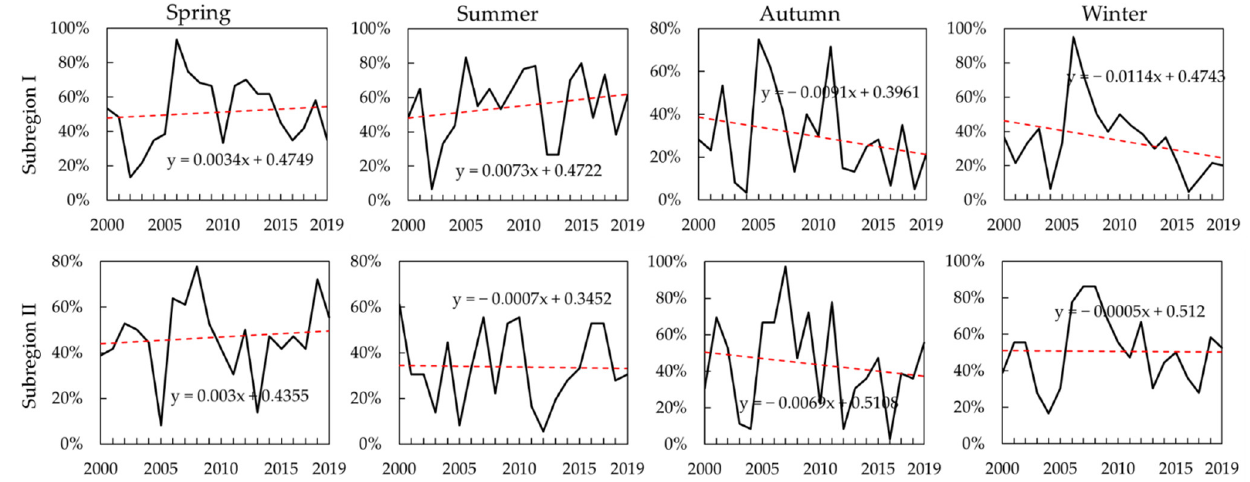
Figure 3. Ranges of mild and more serious droughts in Subregions I and II of Inner Mongolia Autonomous Region.